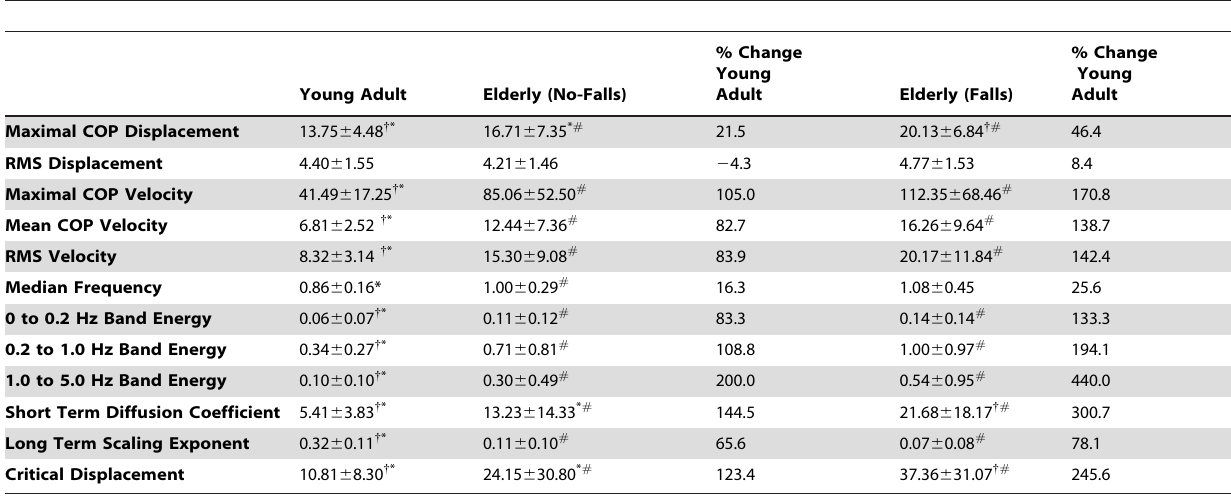
Table 2. Postural Stability Measures of the young adult, elderly without a history of falls, and the elderly population with a self- reported incidence of falls which had occurred in the prior six months.